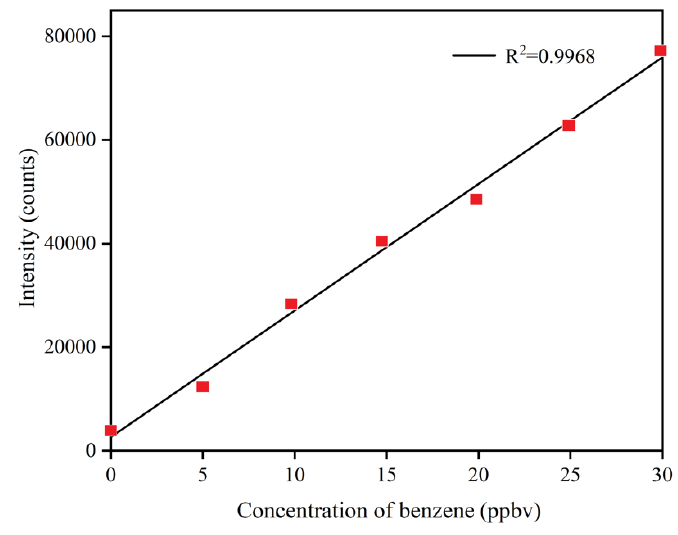
Figure 2. Calibration curve of benzene from 5 ppbv, 10 ppbv, 15 ppbv, 20 ppbv, 25 ppbv and 30 ppbv.